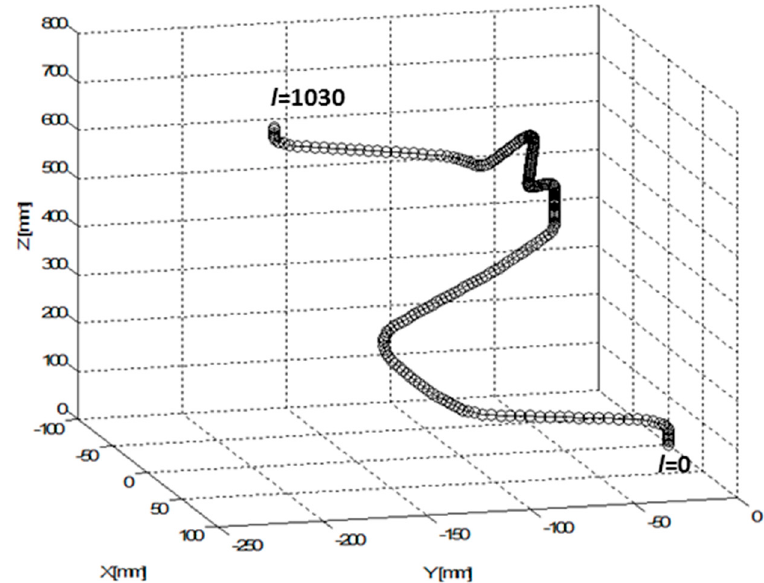
Figure 23. Test 2—3D graphical representation of axis